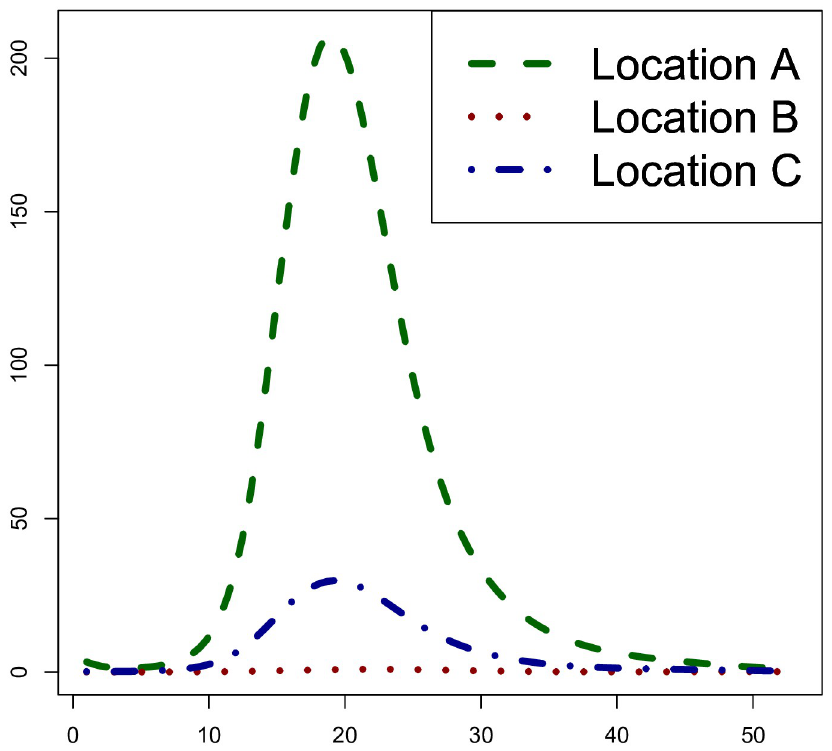
Fig 6. Weekly temporal evolution of Q fever incidence in three specific points (A, B, and C), spatially presented in Fig 4 on the high-resolution map at week 19.